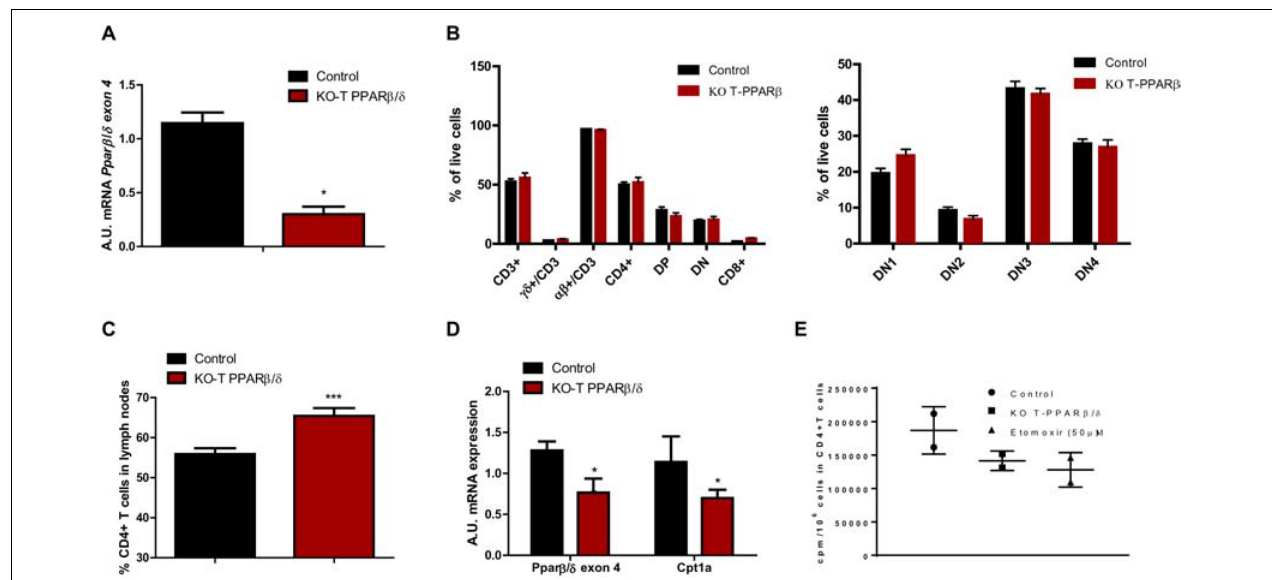
FIGURE 1 | Characterization of T cells in thymus and lymph nodes of young KO-T PPAR β / δ mice compared to young control mice. (A) Ppar β / δ exon 4 mRNA level in T cells . Relative Ppar β / δ mRNA levels in isolated CD3 + T cells from spleen and lymph nodes. Isolation of CD3 + cells was performed using magnetic labeling according to the manufacturer protocol. RNA was extracted as described in “Materials and Methods”; 36B4 has been used as housekeeping mRNA; n = 3 in each group. (B) T cell population analysis in thymus and thymic development of T cells . Cell suspensions from thymus were obtained as described in “Materials and Methods” for cell suspensions from spleen. Left panel, percentages of the different T cell populations in thymus obtained from flow cytometry analyses are shown: CD3 + (and among CD3 + , relative percentages of TCR- αβ and TCR- γδ positive T cells), CD4 + , CD8 + , DN (CD4 - CD8 - ), DP (CD4 + CD8 + ). Right panel, relative percentages of DN1 (CD25 - CD44 + ), DN2 (CD25 + CD44 + ), DN3 (CD25 + CD44 - ), and DN4 (CD25 - CD44 - ) among DN cells are indicated ( n = 6 par group). (C) CD4 + T cell prevalence in lymph nodes in CD3 + T cells . Cell suspensions from lymph nodes were obtained as described in “Materials and Methods.” Flow cytometry analyses were performed to analyze CD4 + in CD3 + cell gating (control, n = 11; KO-T PPAR β / δ , n = 8). (D) Ppar β / δ exon 4 and Cpt1a mRNA expression in lymph nodes . RNA was extracted from lymph nodes cell suspension as described in “Materials and Methods.” The relative amounts of Ppar β / δ and Cpt1a mRNA were quantified using 36b4 as housekeeping mRNA (control, n = 3; KO-T PPAR β / δ , n = 5). (E) Palmitate oxidation of isolated CD4 + T cells . FAO was measured as 3 H-palmitate conversion to 3 H 2 O and quantified as CPM/10 6 cells in in vitro -activated CD4 + cells treated or not with 50 µ M etomoxir ( n = 2 per group). Values are presented as box and whiskers min to max. Except for (E) , values are mean ± SD. Statistical analyses were performed using Mann–Whitney U -test.* p < 0.05, different from control mice. TABLE 1 | Effects of age and genotype on body composition. Control Cre ( n = 28) KO T PPAR β / δ ( n = 27)